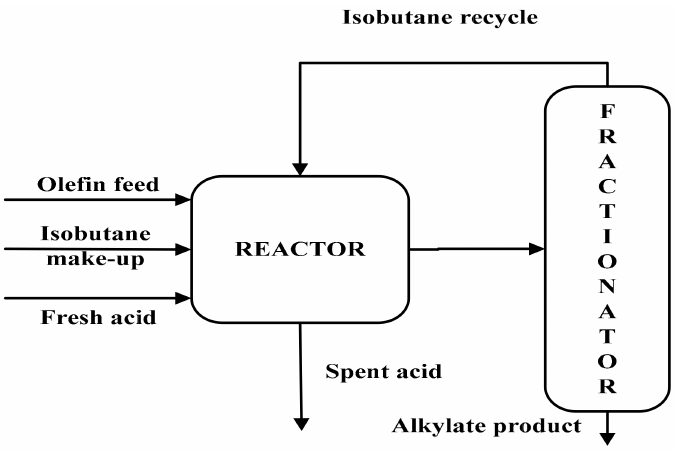
Figure 6. The flowsheet of the simplified alkylation process.